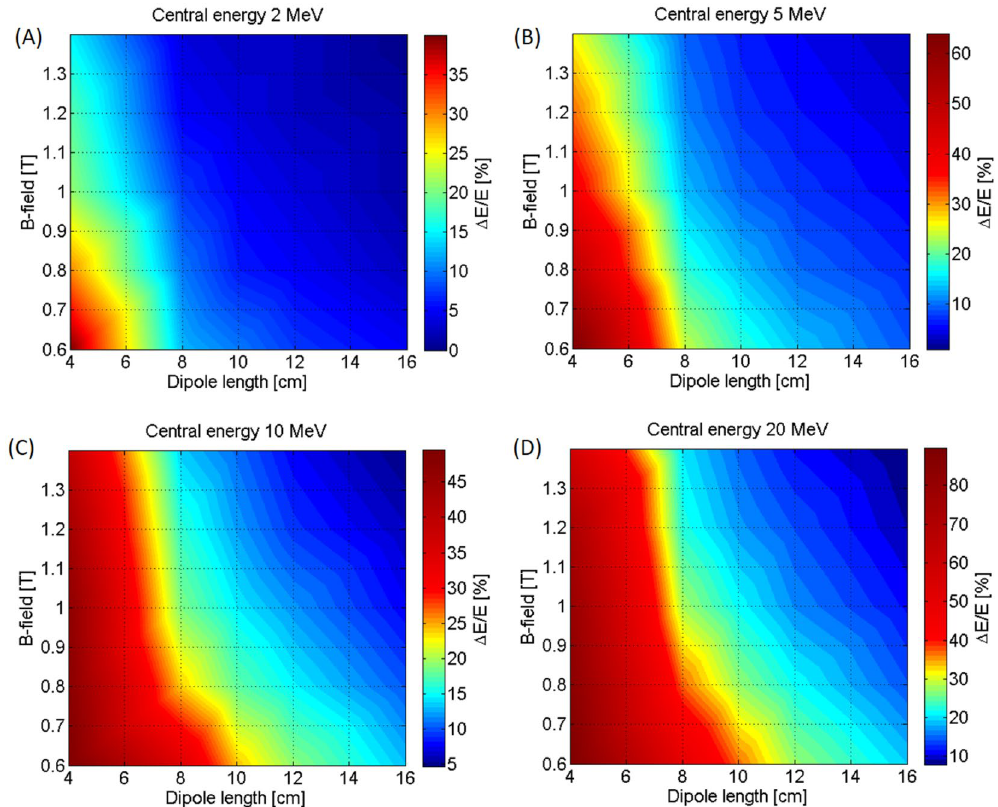
Figure 2. Final energy spread of the proton beam (indicated in the color bar) at the exit of the ES, as a function of the dipole length (x-axis) and magnetic field (y-axis). The maps indicate different mean energies of the selected beam (( A ) 2 MeV, ( B ) 5 MeV, ( C ) 10 MeV and ( D ) 20 MeV). The initial divergence of the beam is 3 mrad half-angle for all the cases and the aperture of the selecting slit is 500 µ m. By fixing the desired final energy spread value it is possible to identify in the maps the required combination of l point.